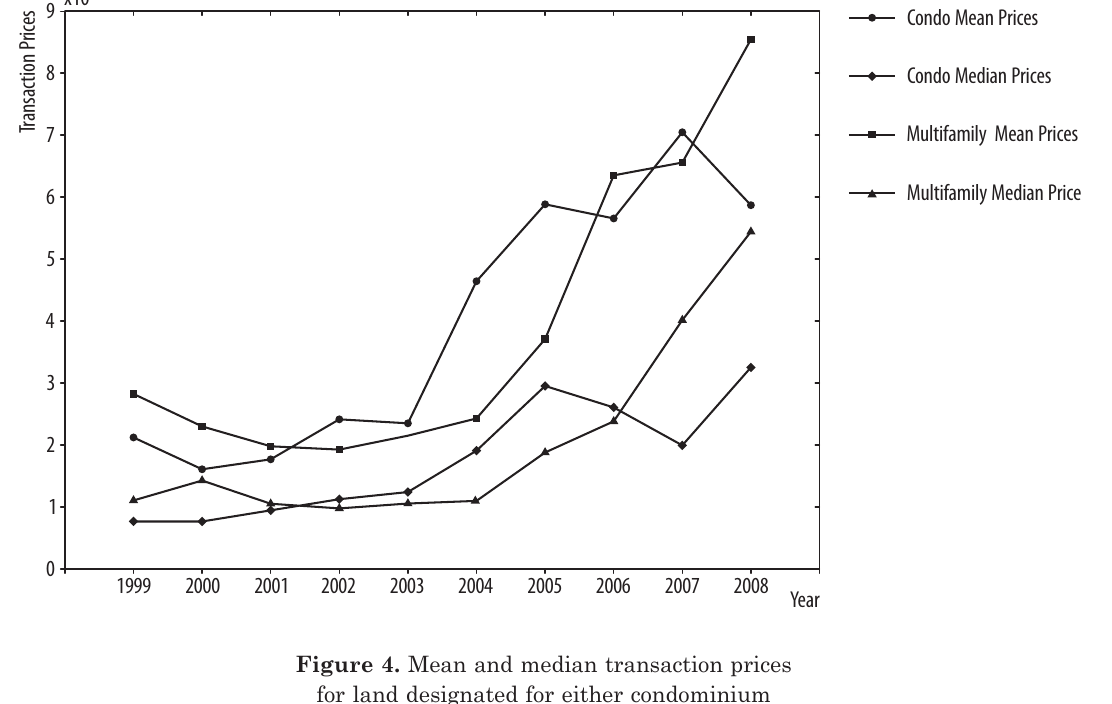
Figure 4. mean and median transaction prices for land designated for either condominium or multifamily